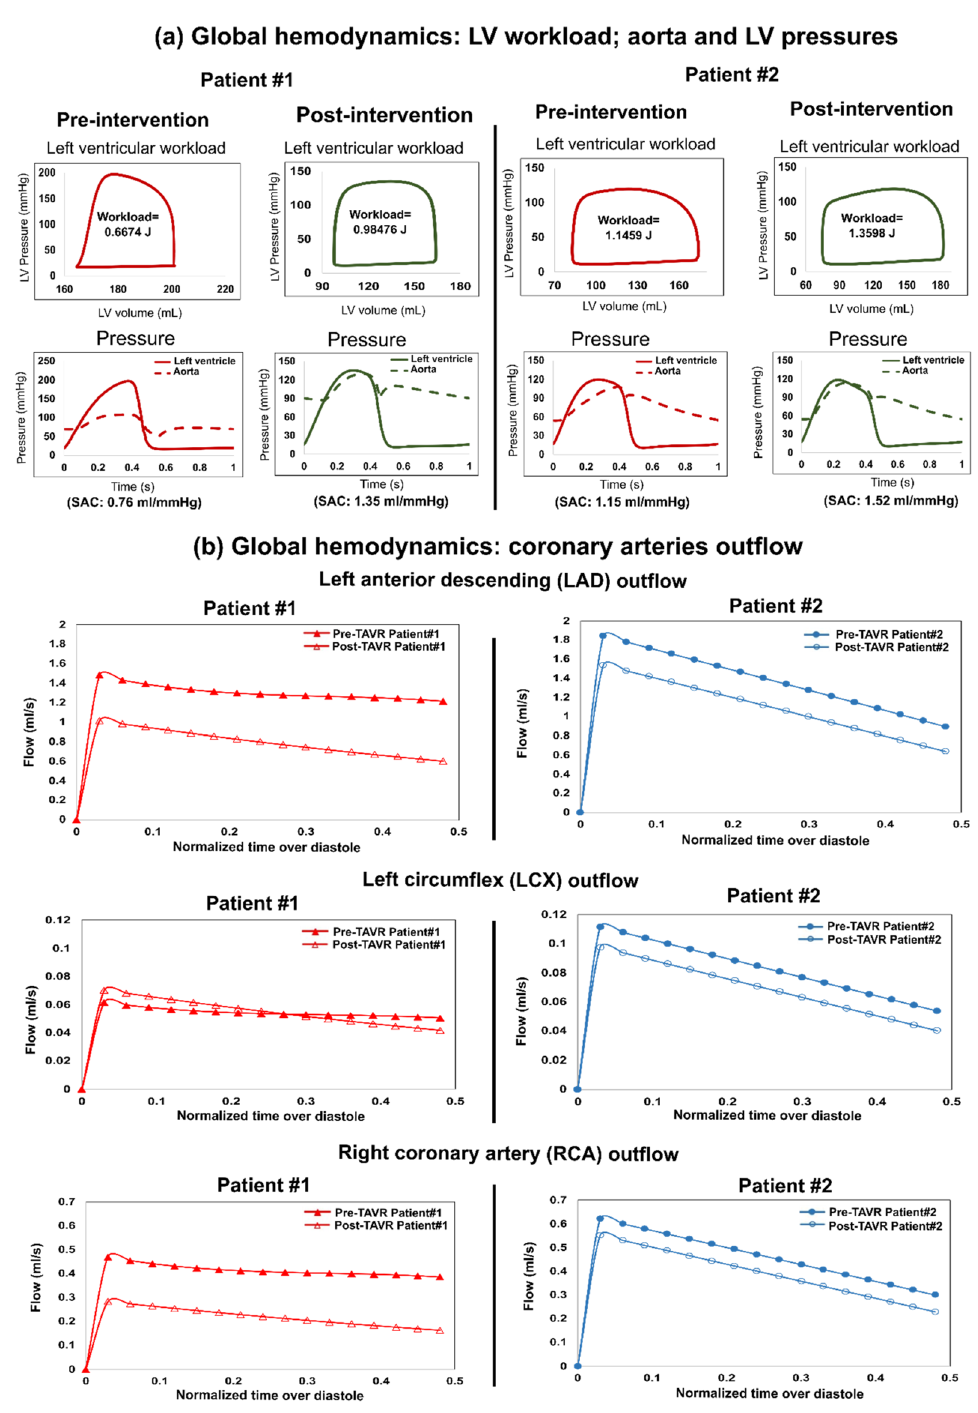
Figure 14. Global hemodynamics. Changes in predicted global hemodynamics before intervention and after TAVR for patients#1 and #2; ( a ) workload, left ventricle and ascending aorta pressure and systemic arterial compliance (SAC); ( b ) Changes in predicted coronary flowrate for LAD, LCX and RCA branches before intervention and after TAVR for both